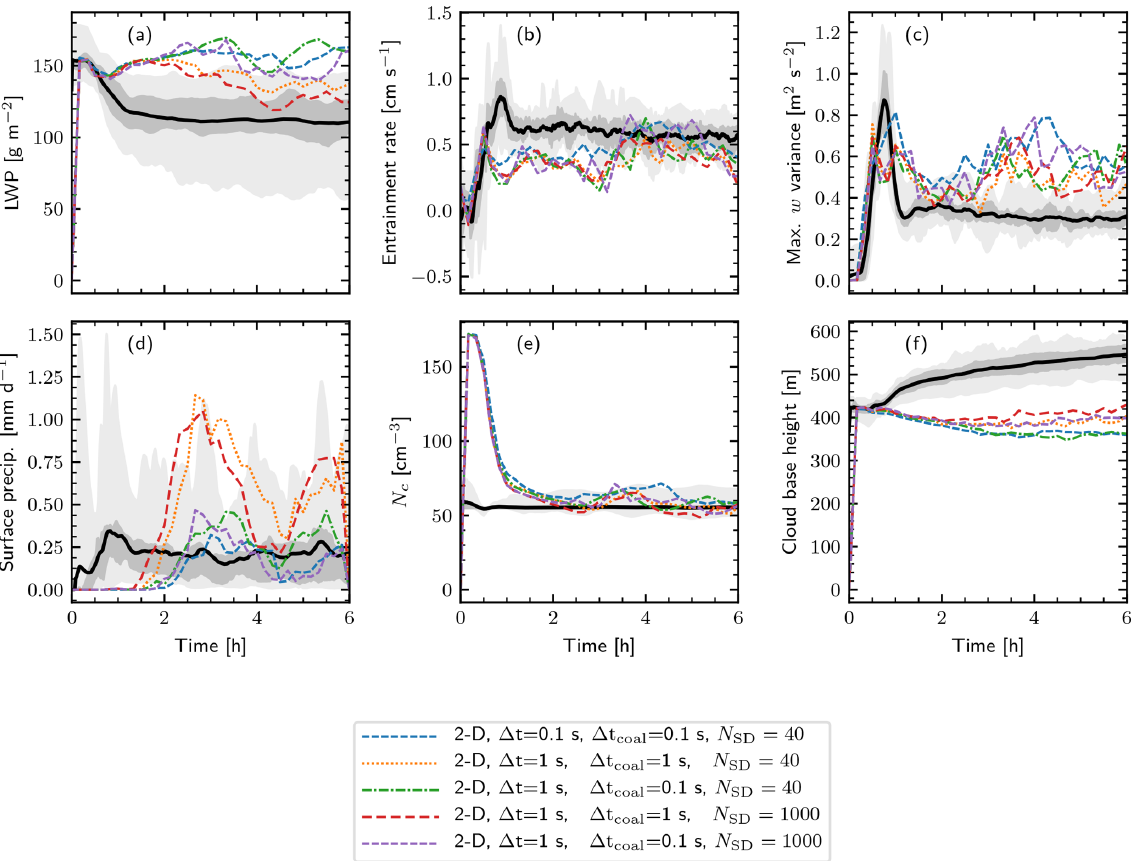
Figure 3. The 2-D UWLCM results. Time series of the domain averaged liquid water path, entrainment rate (equal to d z i / d t + w LS z i ), vertical velocity variance VAR (w) maximum, surface precipitation, concentration of cloud droplets in cloudy cells and cloud base height. UWLCM simulations were carried out for different model and coalescence time steps and different initial numbers of SDs per cell. Each colored line represents an average from 10 UWLCM simulations of a given type. Results of 3-D simulations from an ensemble of 11 models are shown for reference (Ackerman et al., 2009). The mean, the middle two quartiles, and the range of that reference ensemble are plotted using the black solid line, the dark shaded region and the light shaded region,